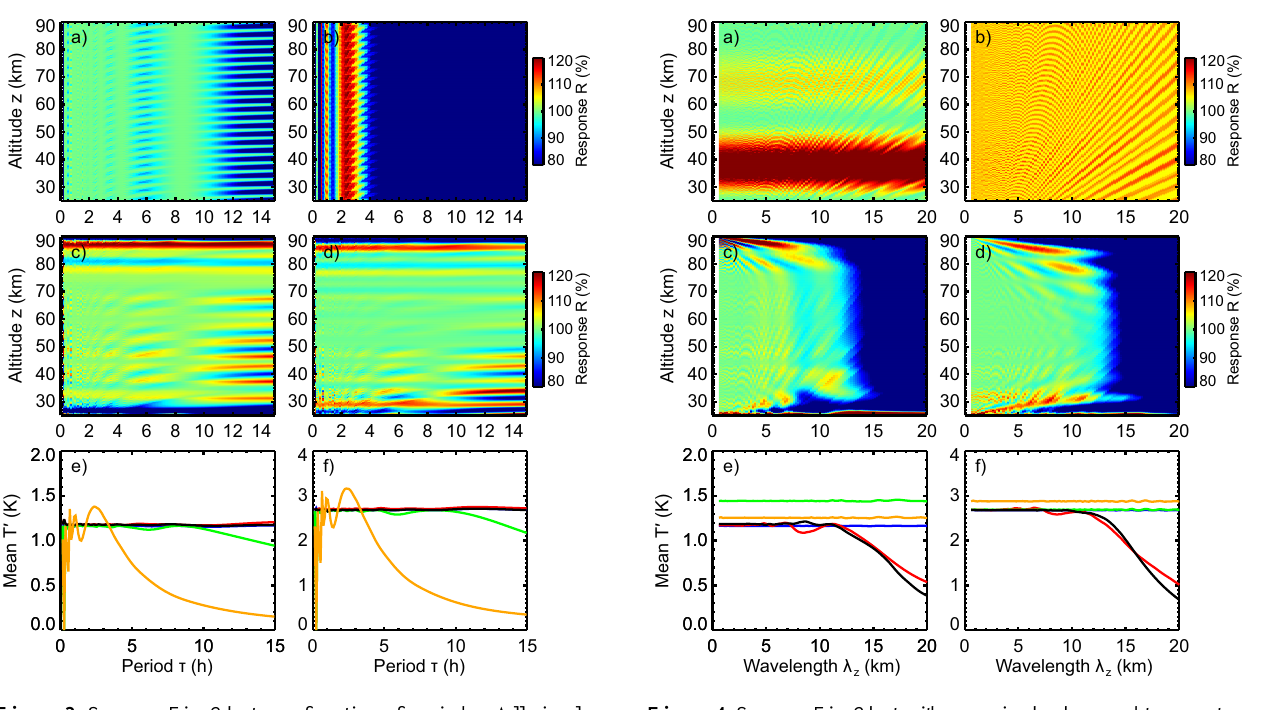
Figure 3. Same as Fig. 2 but as a function of period τ . All simula- tions were carried out with a fixed vertical wavelength of 6km and a background temperature profile constant in time. Note that the blue and black lines in (e) and (f) are lying on top of each other.